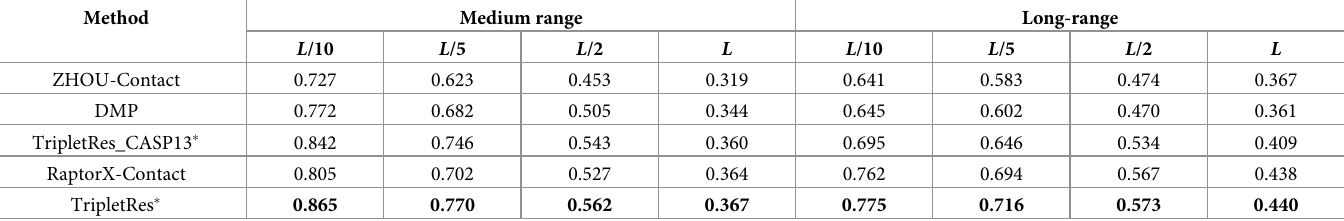
Table 2. Performance comparisons on CASP13 FM targets between TripletRes and RaptorX-Contact, DMP, and ZHOU-Contact servers, sorted in ascending order of top L long-range contact precision.